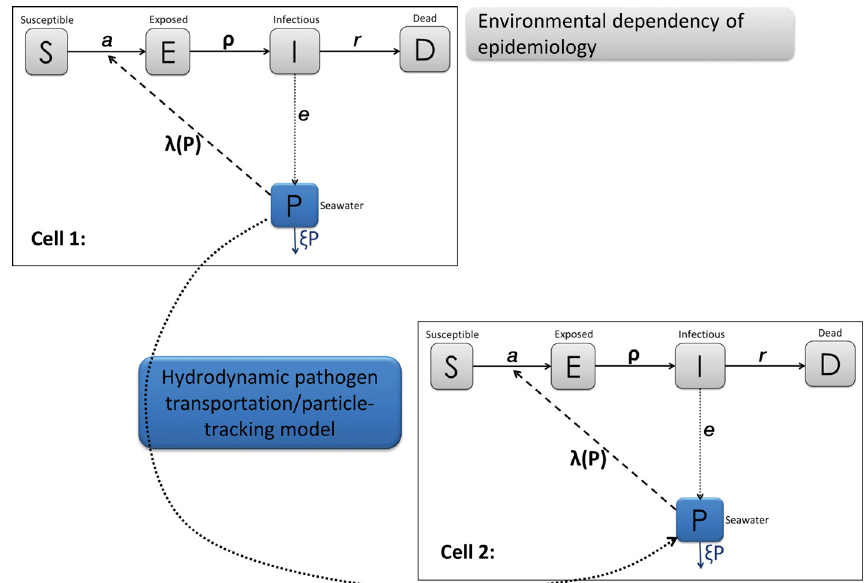
demiological parameters, (iii) local spread of patho- gens, and (iv) tidal hydrodynamics. The modelling framework components are described in Fig. 2. The workflow of the model setup and outputs is shown in Fig. 3.